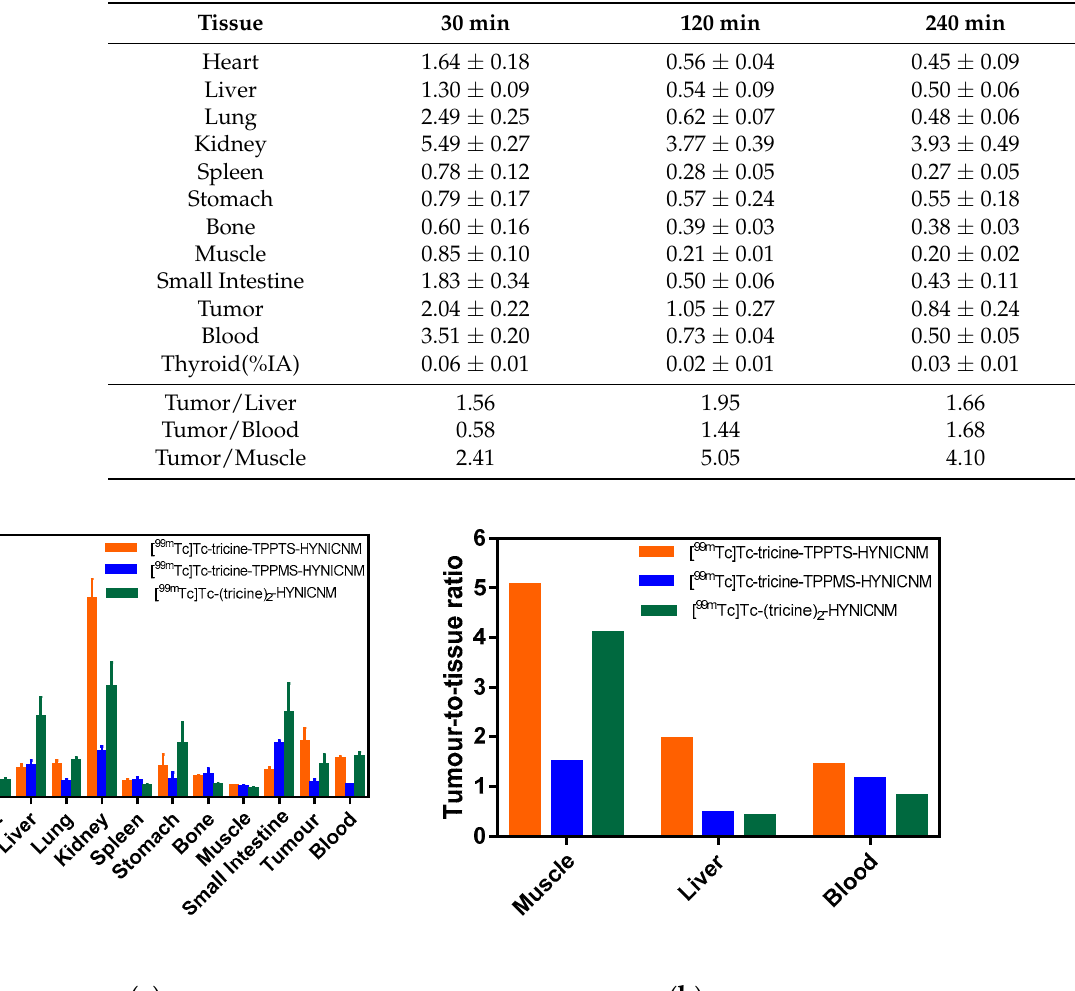
Table 1. Biodistribution of [ 99m Tc]Tc-tricine-TPPTS-HYNICNM in Kunming female mice bearing